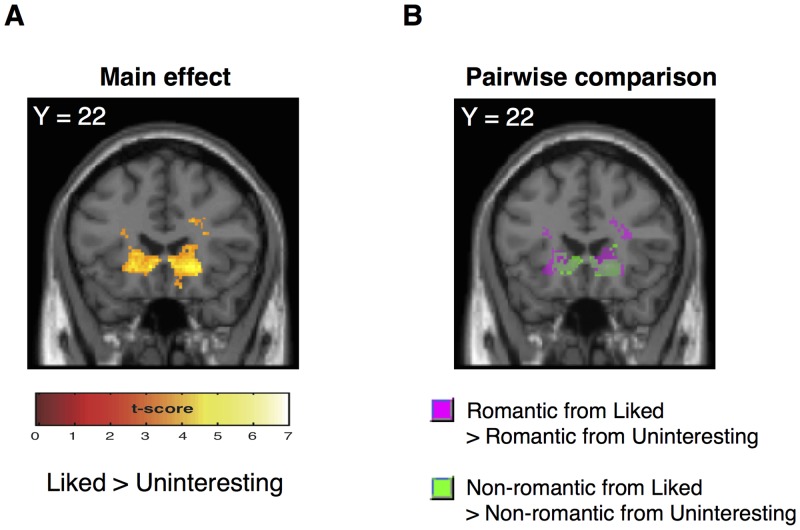
Brain activation for the effect of the givers.(A) Significant activation was found in the bilateral caudate with a main effect of giver (liked vs. uninteresting). (B) Superimposed significant activations in the bilateral caudate for a pairwise comparison between givers for romantic (in purple) and non-romantic (in green) gifts (i.e., romantic/non-romantic gifts from the liked vs. the uninteresting giver). All activations are displayed at a threshold of p < 0.001, uncorrected at the voxel-level.